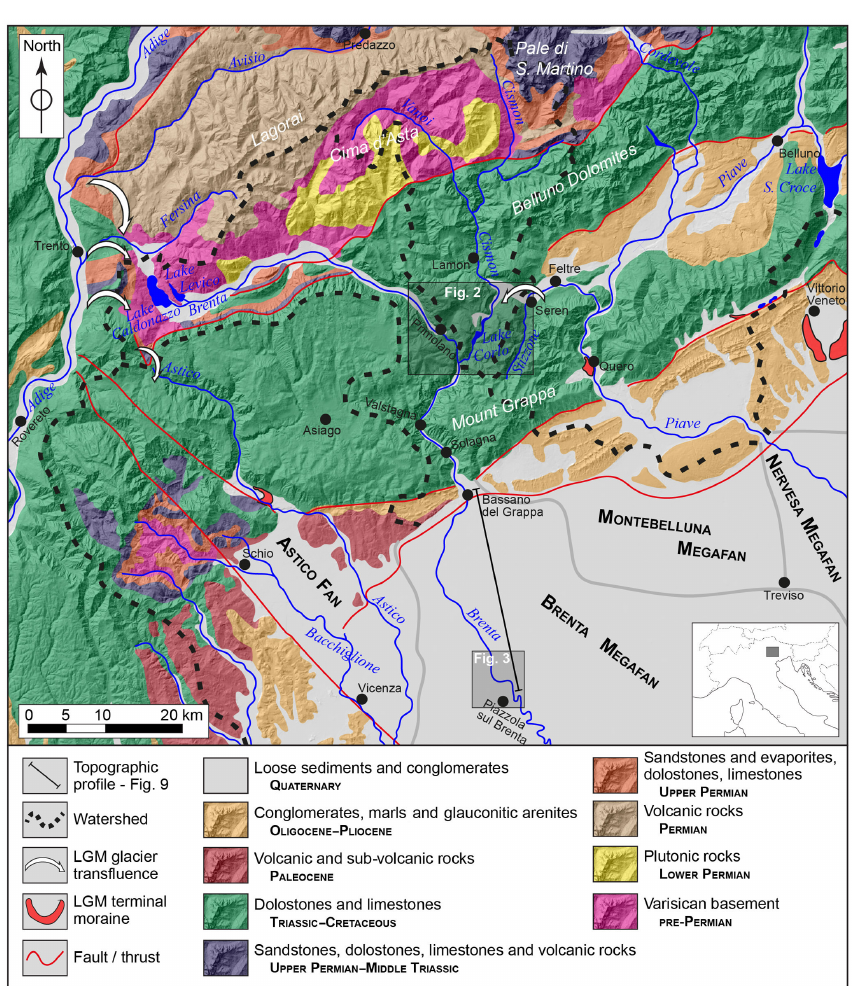
Figure 1. A geological sketch of the study area. The map is based on the “Structural model of Italy” (Bigi et al., 1990) and local geological maps (Bartolomei et al., 1969; Dal Piaz et al., 1946; Barbieri and Grandesso, 2007; Avanzini et al., 2010). It also overlies a Shuttle Radar Topography Mission (SRTM) derived digital elevation model (DTM; 30m cell size) (source: http://viewfinderpanoramas.org/, last access: 12 April